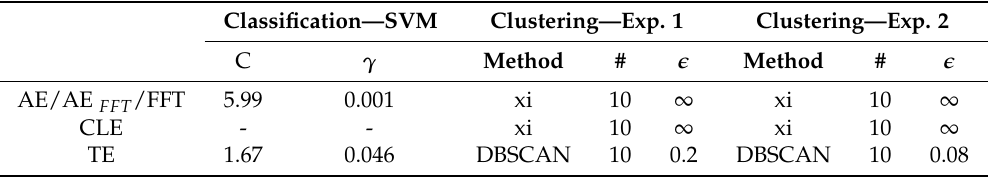
Table 2. Classification and clustering hyperparameters based on the feature spaces of the FFT, the Autoencoder based on the FFT (AE FFT ), the Autoencoder (AE), the Classifier Encoder (CLE), and Triplet Encoder (TE) Models.